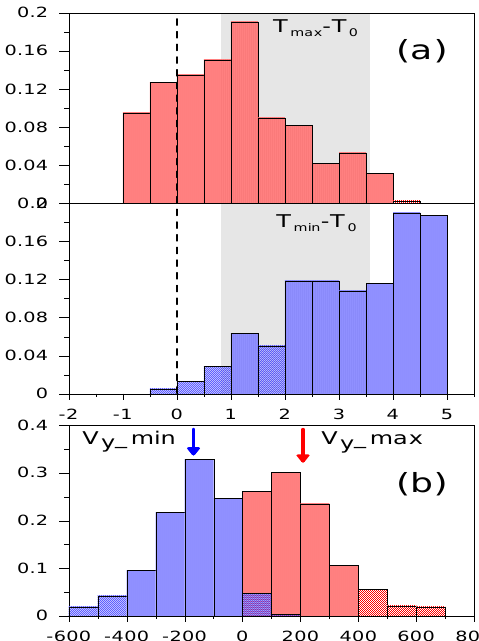
Figure 9 a) Histograms of the time delay of the Fig. 9. (a) Histograms of the time delay of the maximal (top) and maximal (top) and minimal (bottom) Vy velocity value relative to the time of BBFs front pass (dashed minimal (bottom) V y velocity value relative to the time of the BBFs’ line); b) histograms of the minimal (left) and maximal front pass (dashed line); (b) histograms of the minimal (left) and (right) Vy value maximal (right) V y value.